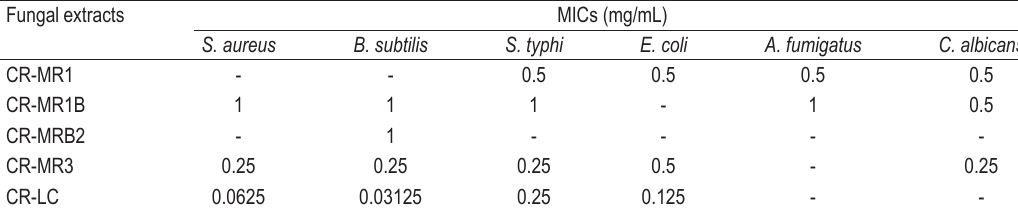
TABLE 2. The MICs of fungal extracts against the test organisms Fungal